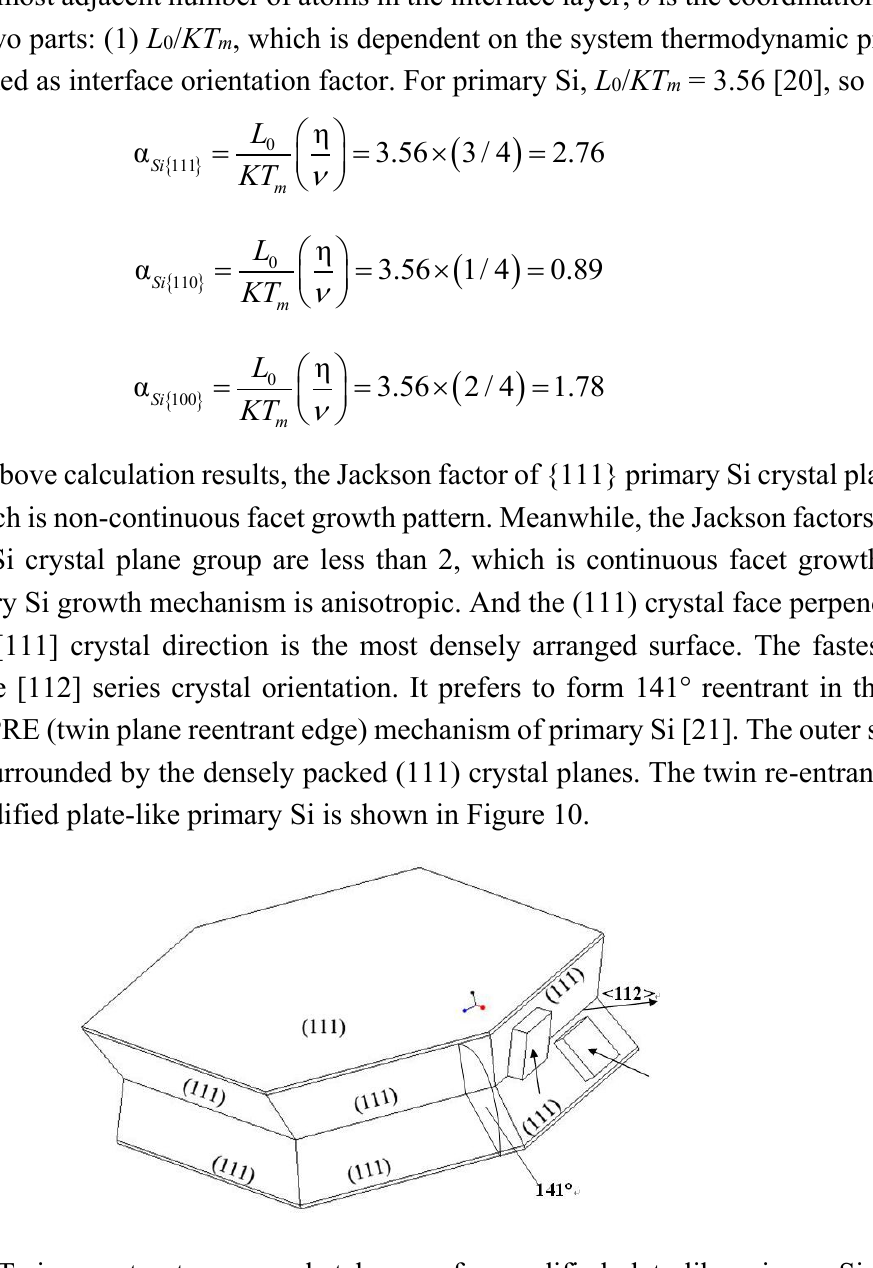
Figure 10. Twin re-entrant grooves sketch map of unmodified plate-like primary